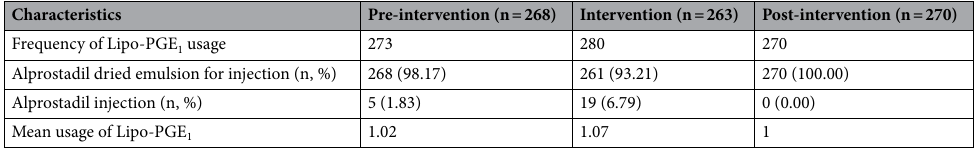
Table 5. The use of Lipo-PGE 1 in pre-, during, and post-intervention periods.